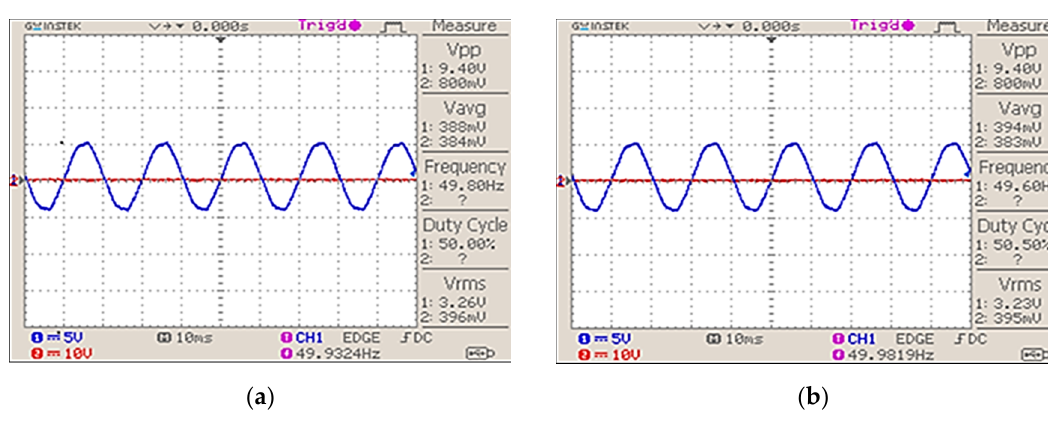
Figure 15. Grid current during ( a ) starting and ( b ) execution.